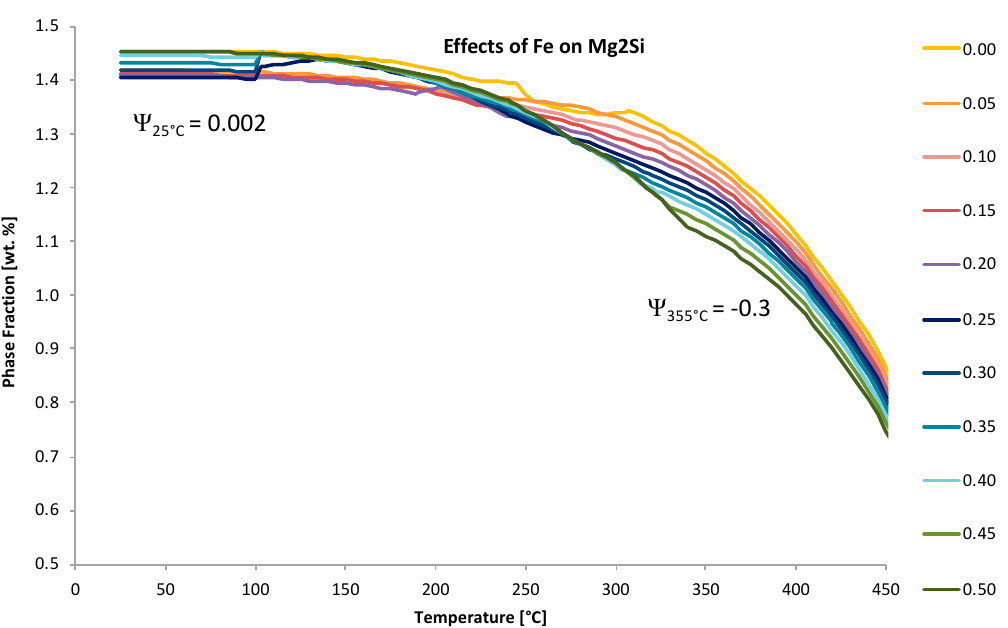
Figure 18. ( a ) The resulting phase fractions of Al 13 Cr 4 Si 4 and Al 45 Cr 7 as a function of chromium content. ( b ) The isopleth of Al 6061 with varying chromium contents. The orange shaded region in ( b ) represents the presence of Al 13 Cr 4 Si 4 , whereas the grey shaded region in ( b ) represents Al 45 Cr 7 .